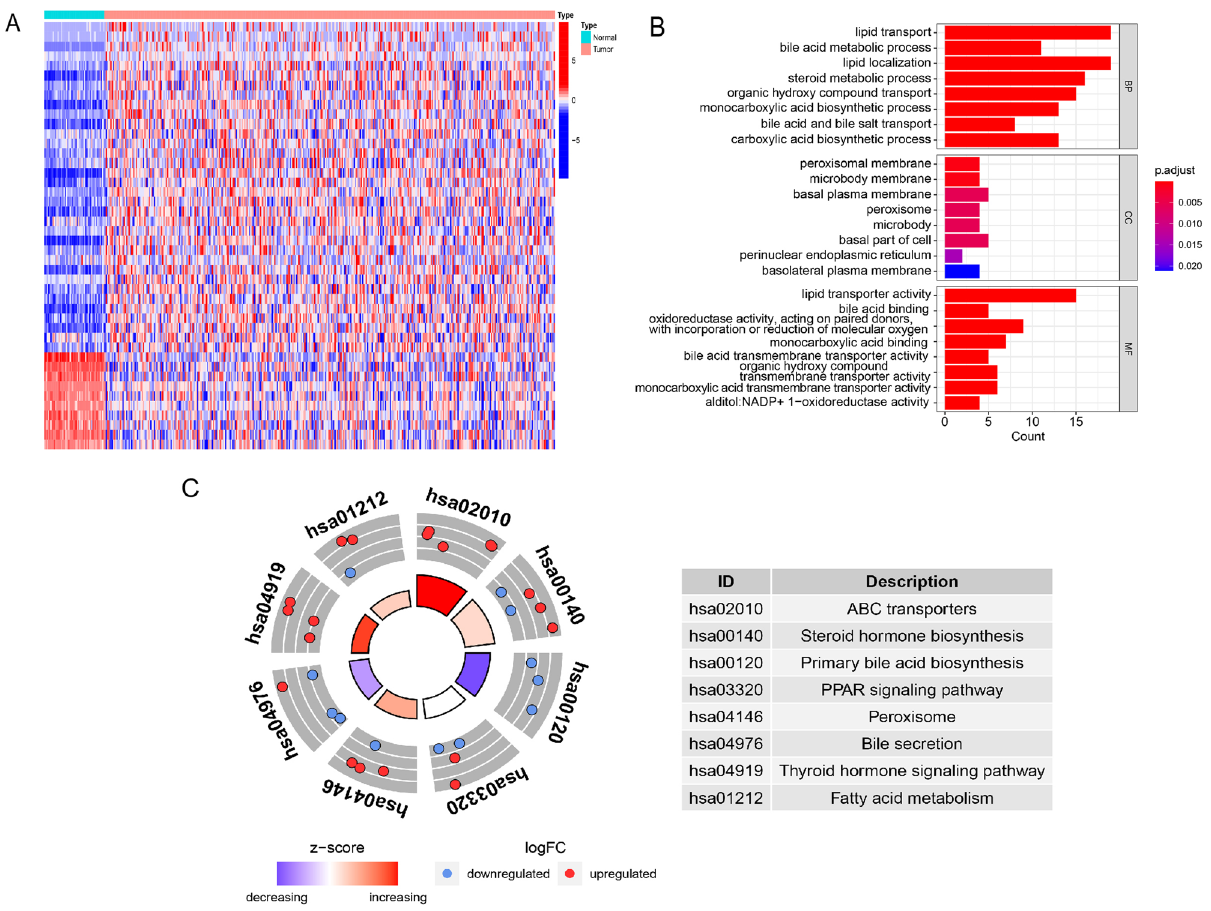
proje ct. org/). ( B ) GO analysis of differential BAGs. ( C ) KEGG analysis of differential